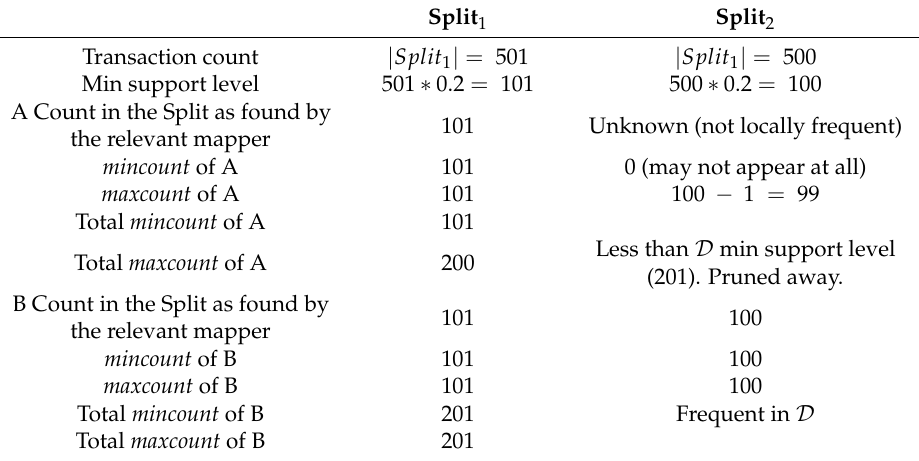
Table 4. Early pruning example values for D .